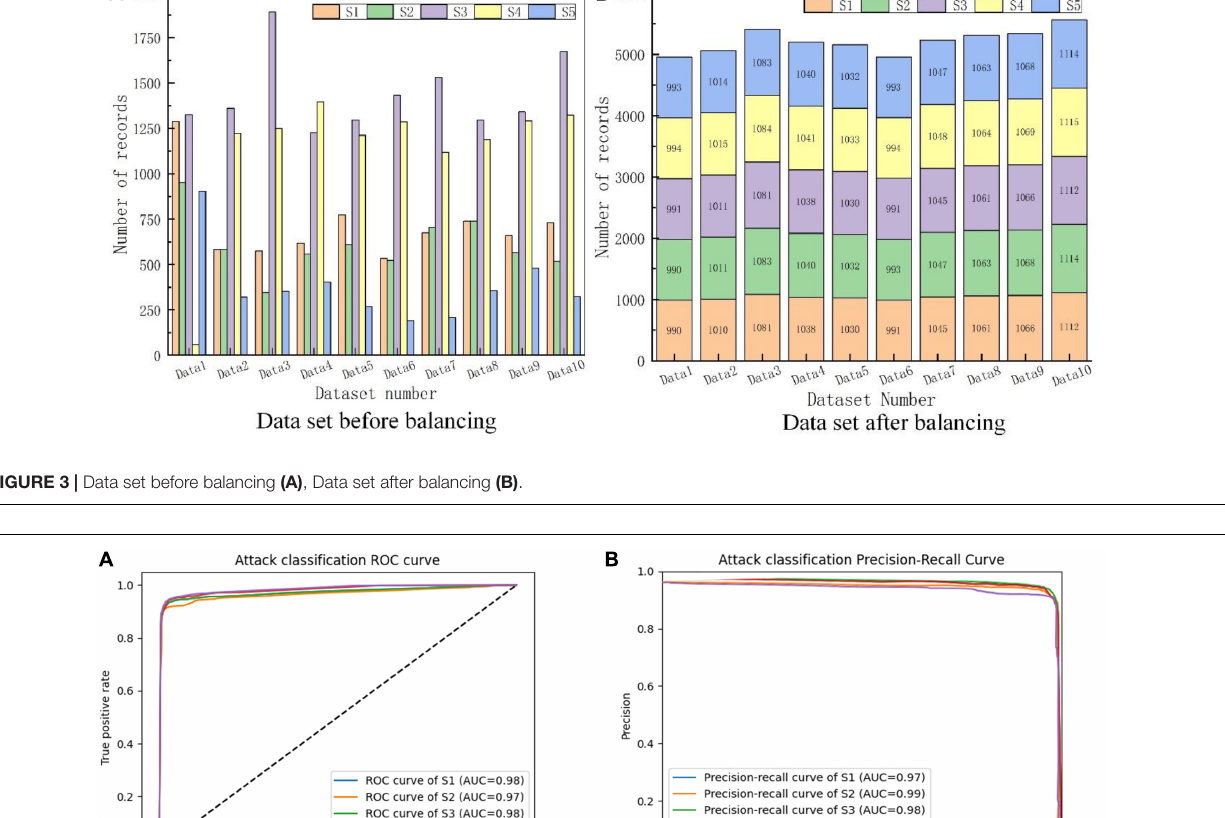
Frontiers in Energy Research |